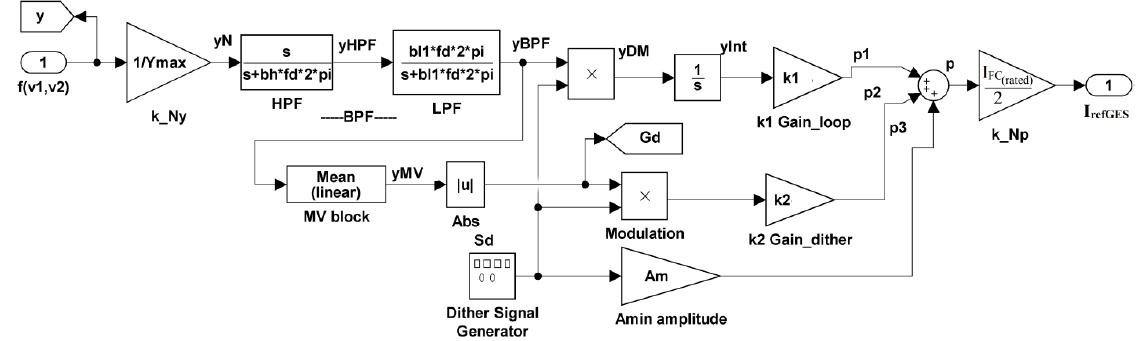
Figure 2. The GES